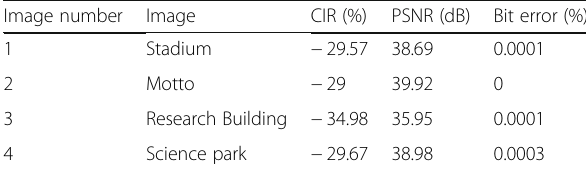
Table 2 Experiments for different images when quality is 90 Image number Image